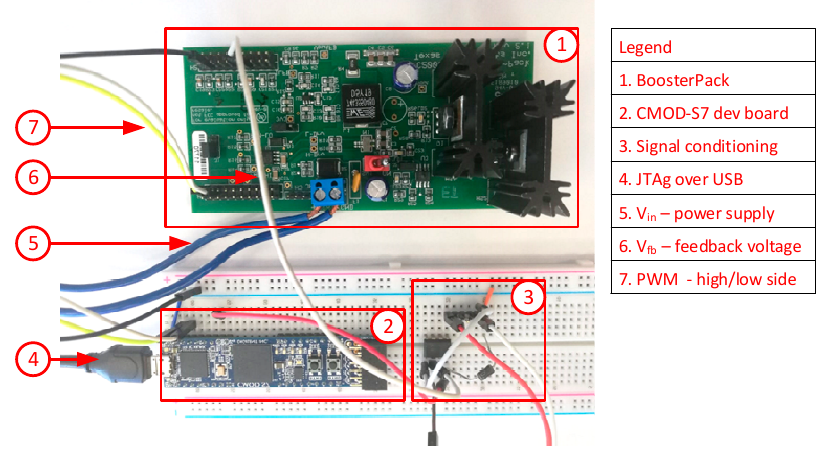
Figure 10. PID controller on a CMOS-S7 module and TI’s BoosterPack buck power stage.